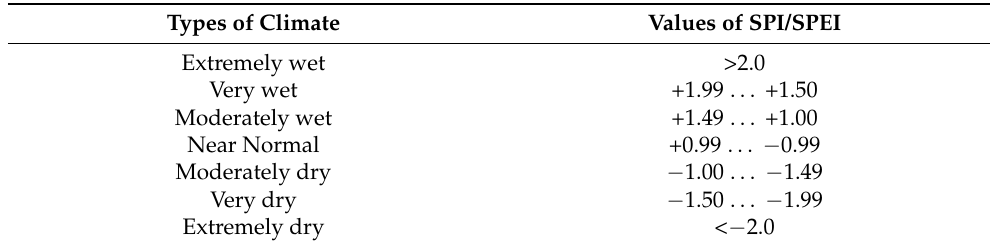
Table 2. Drought classification for the Standardized Precipitation Index (SPI) and Standardized Precipitation Evapotranspiration Index (SPEI).